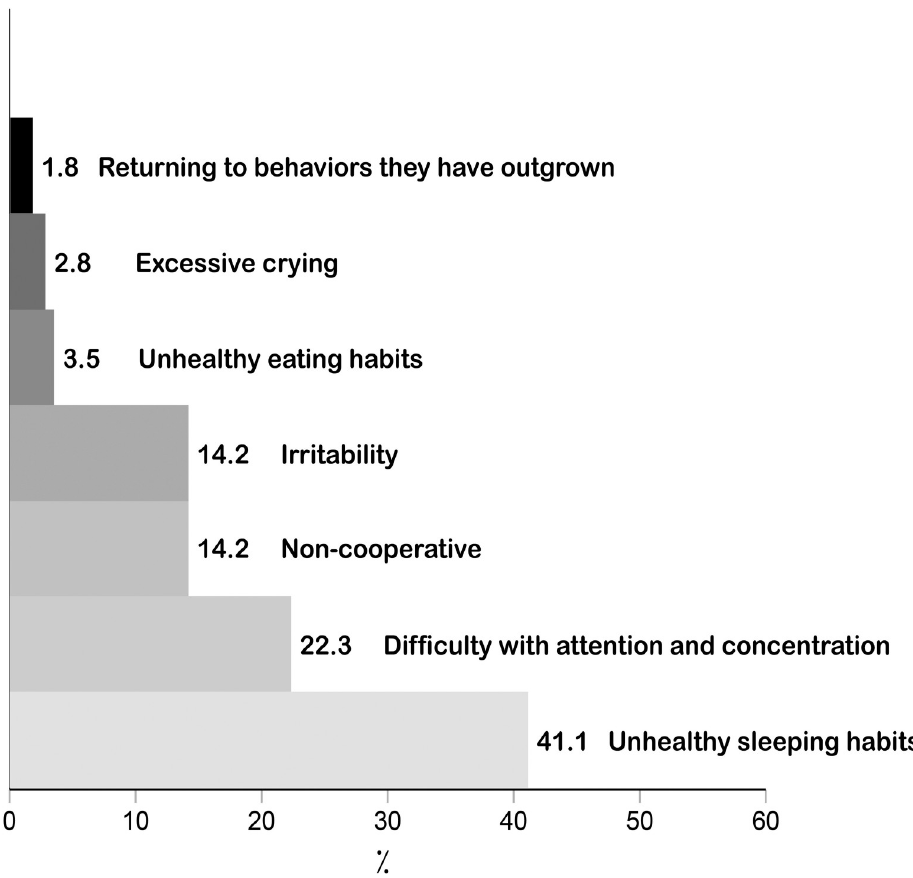
Fig 3. Perceived change in children’s behavior during COVID-19 lockdown (n = 564).